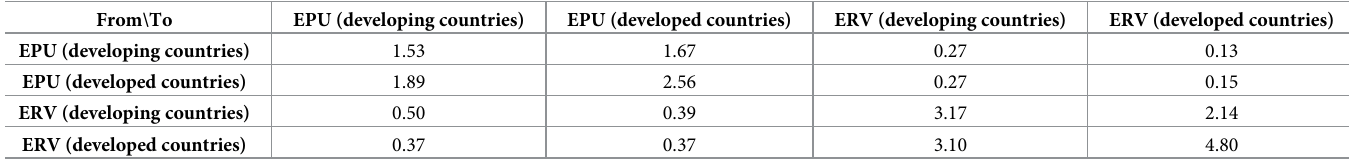
Table 3. Average spillover effects between EPU and ERV in developed and developing countries.